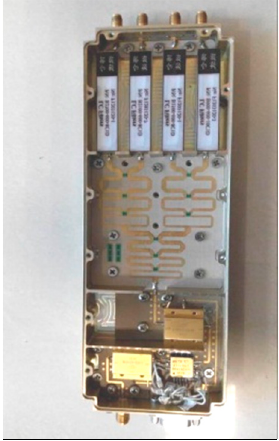
Figure 12. The RF front-end.